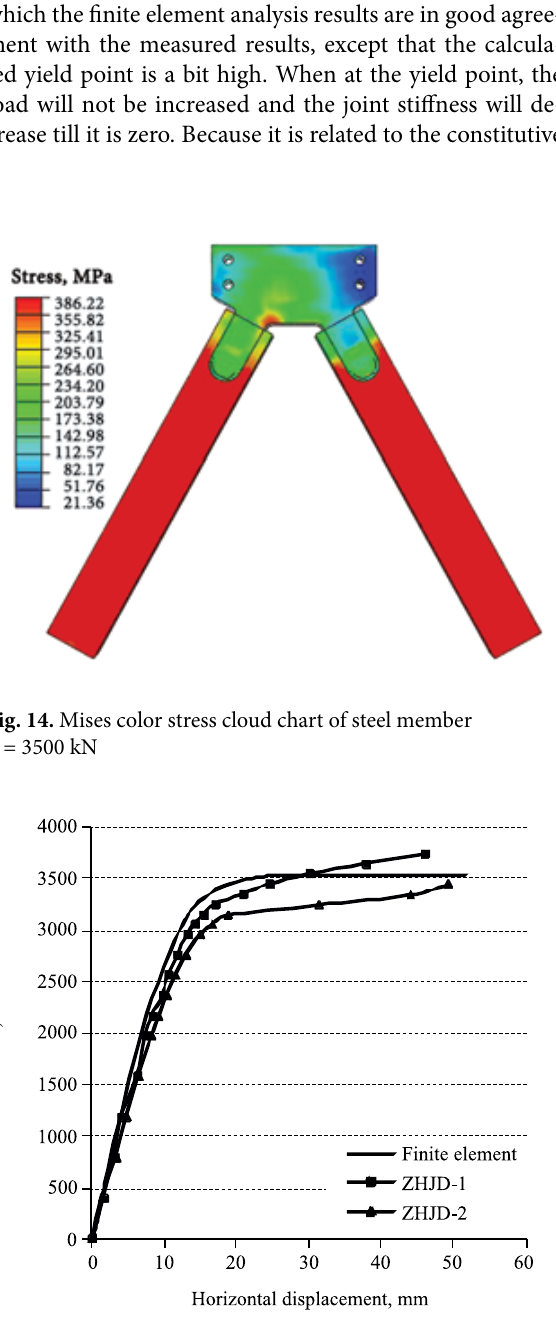
Fig. 15. Comparison of load-displacement curves of